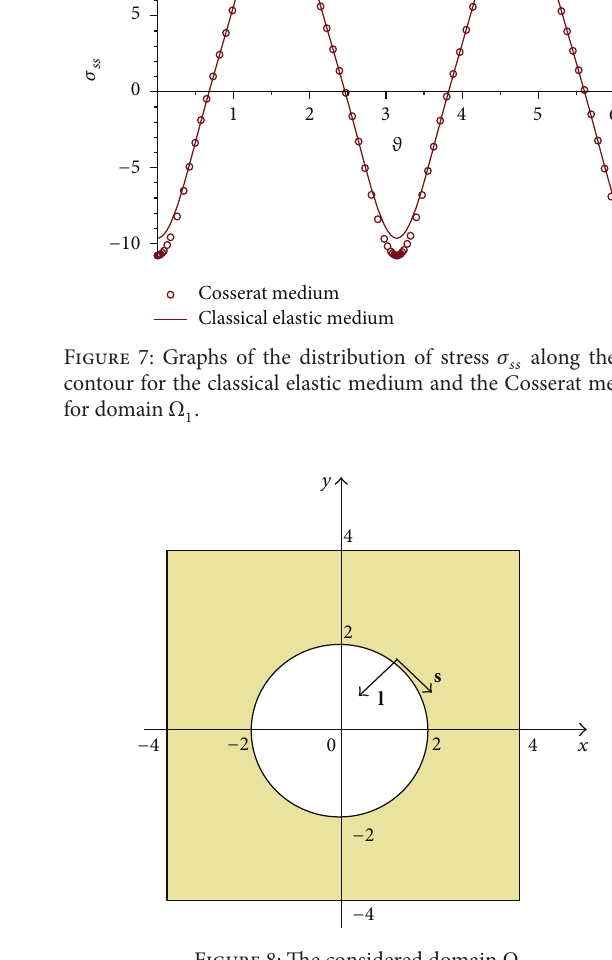
Figure 8: The considered domain Ω 2